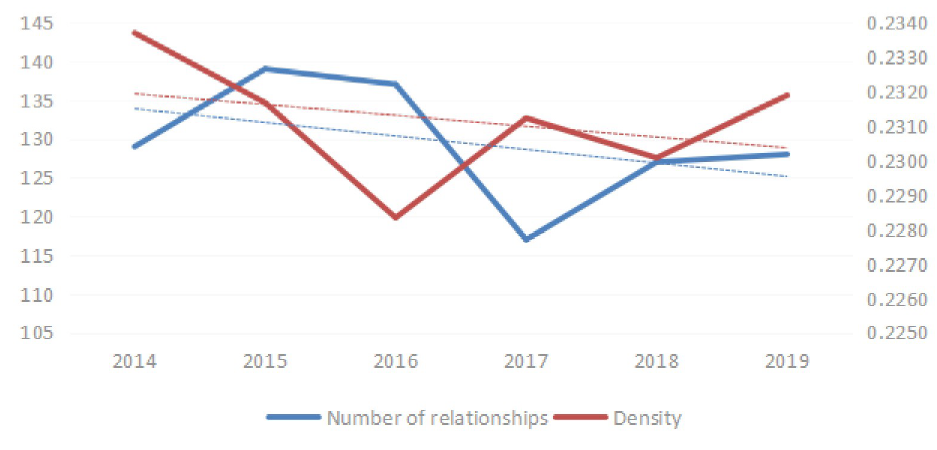
Fig 2. Trends in network density and number of relationships in China’s new energy vehicle industry.